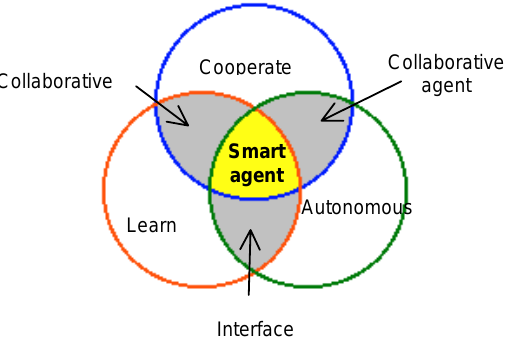
Figure 3. An agent topology according to